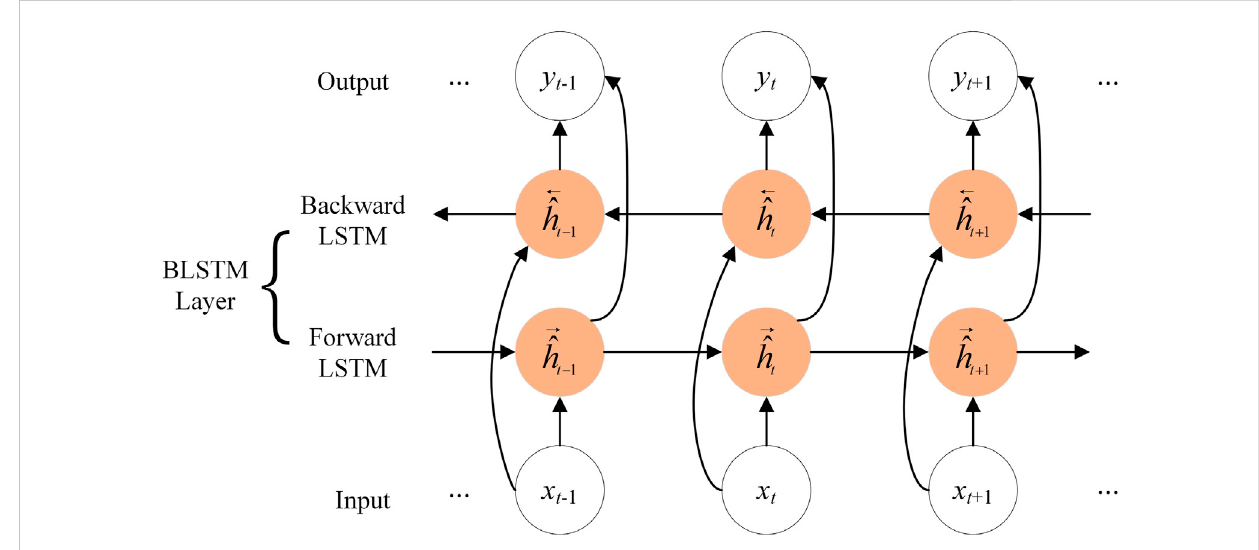
FIGURE 1 The architecture of